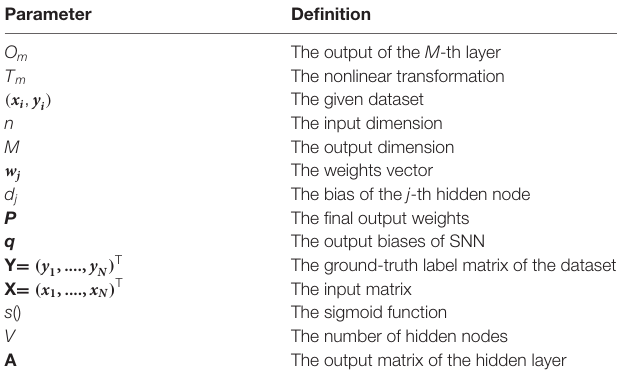
TABLE 4 | Pseudocode of the proposed DSNN. Step 1: Load the pre-trained DenseNet. Step 2: Modify the pre-trained